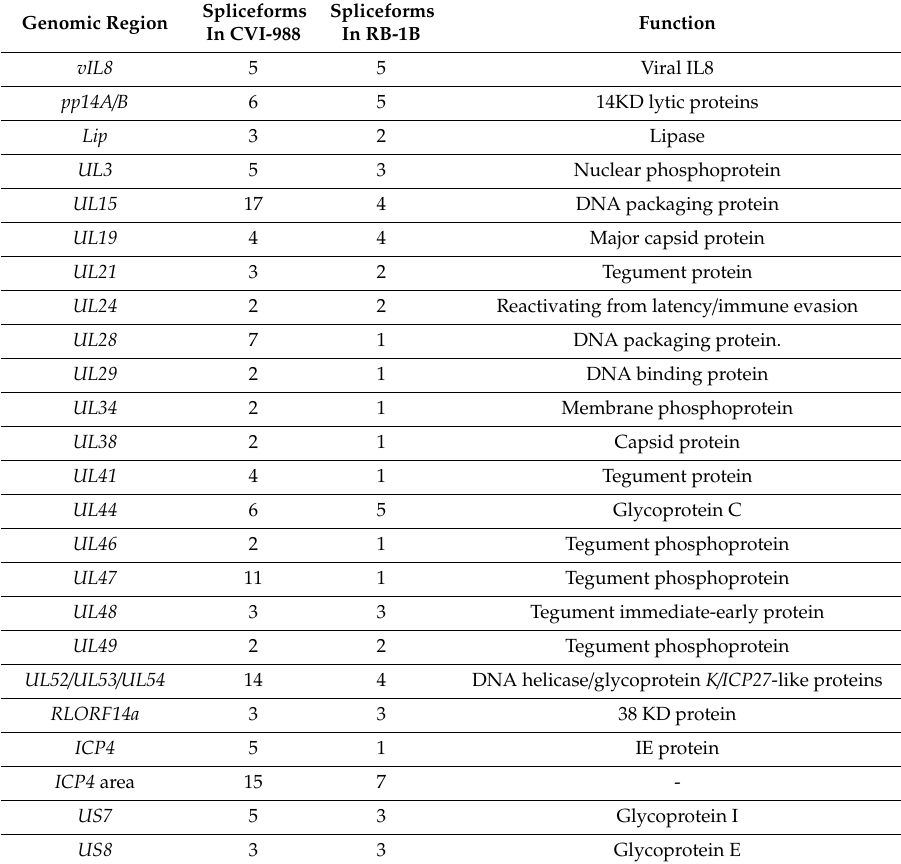
Table 2. Enumeration of putative novel coding splicing isoforms for several MDV genes, as deduced from introns observed in CEF cells infected by MDV strains RB-1B and CVI-988.